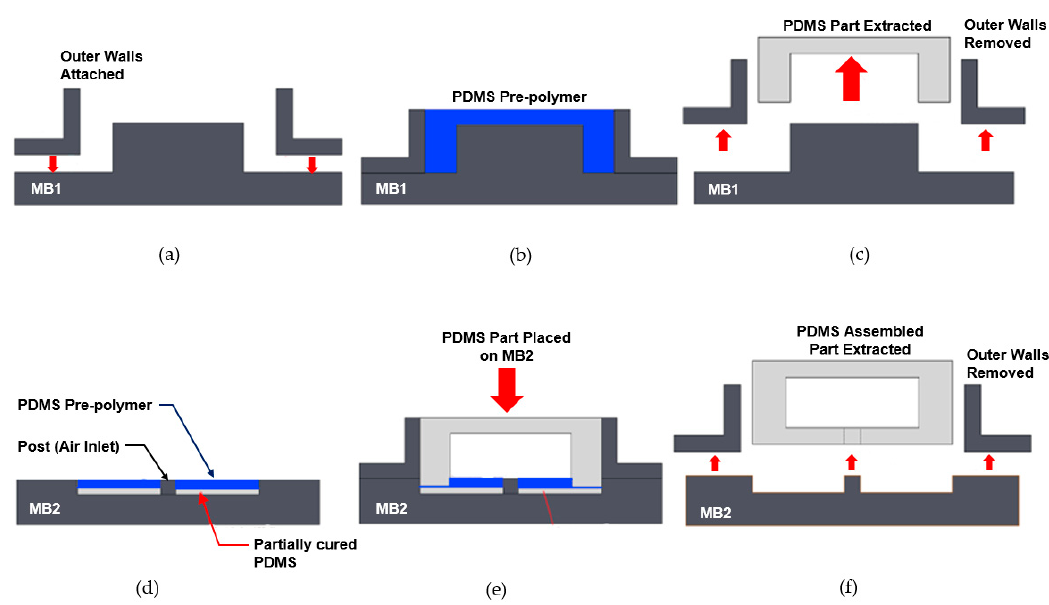
Figure 7. The PDMS actuator fabrication process. ( a ) Assembly of outer walls on the base for MB1